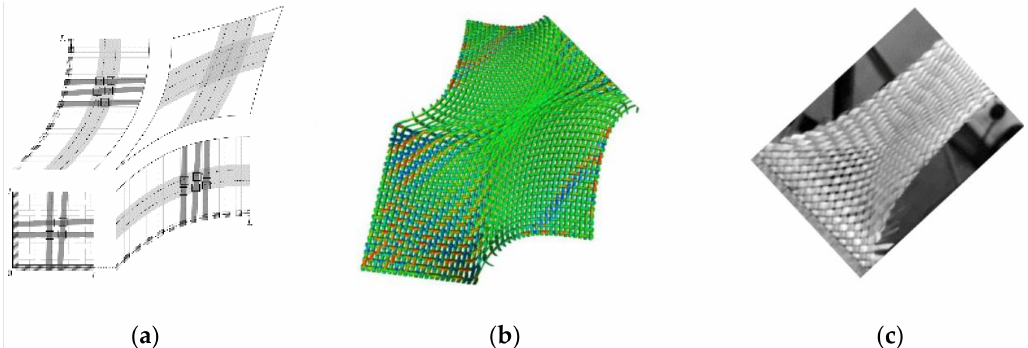
Figure 7. ( a ) Schematic deformation of yarns with a weak contact (small friction) obtained by asymptotic analysis in [5,6]; ( b ) its numerical implementation; ( c ) experiment showing a shear